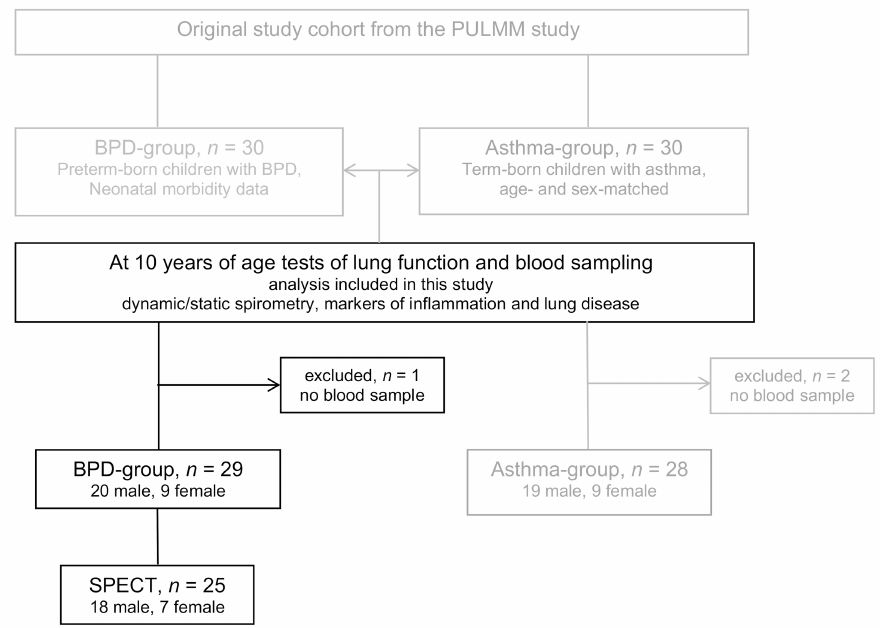
Figure 1. Flow chart of eligible patients from the original cohort of the PULMM study (PrematUre follow up with Lung function Mannitol and Methacholine). The final cohort included 29 children born preterm with bronchopulmonary dysplasia (BPD) at ten years of age. Lung function with spirometry, YKL-40 and relative telomere length (RTL) was analyzed in all children, and three-dimensional V/Q- scintigraphy (single photon emission computer tomography, SPECT) was analyzed in a subgroup of 25